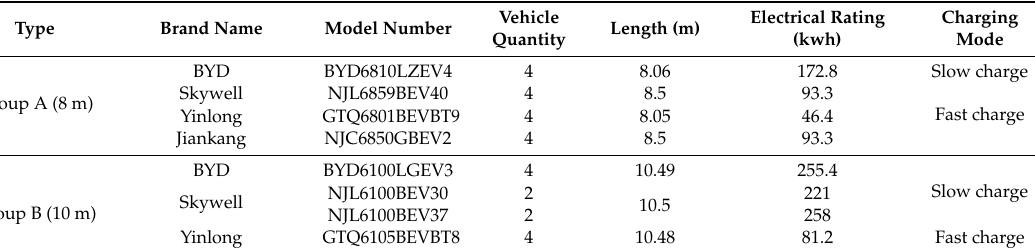
Table 1. Vehicle Brand Involved in the Test.